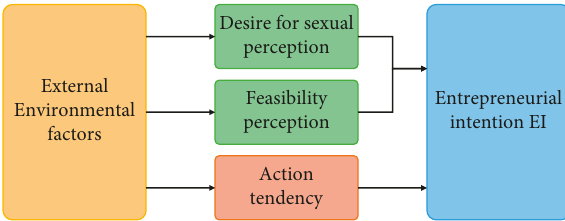
Figure 4: Entrepreneurial event model.